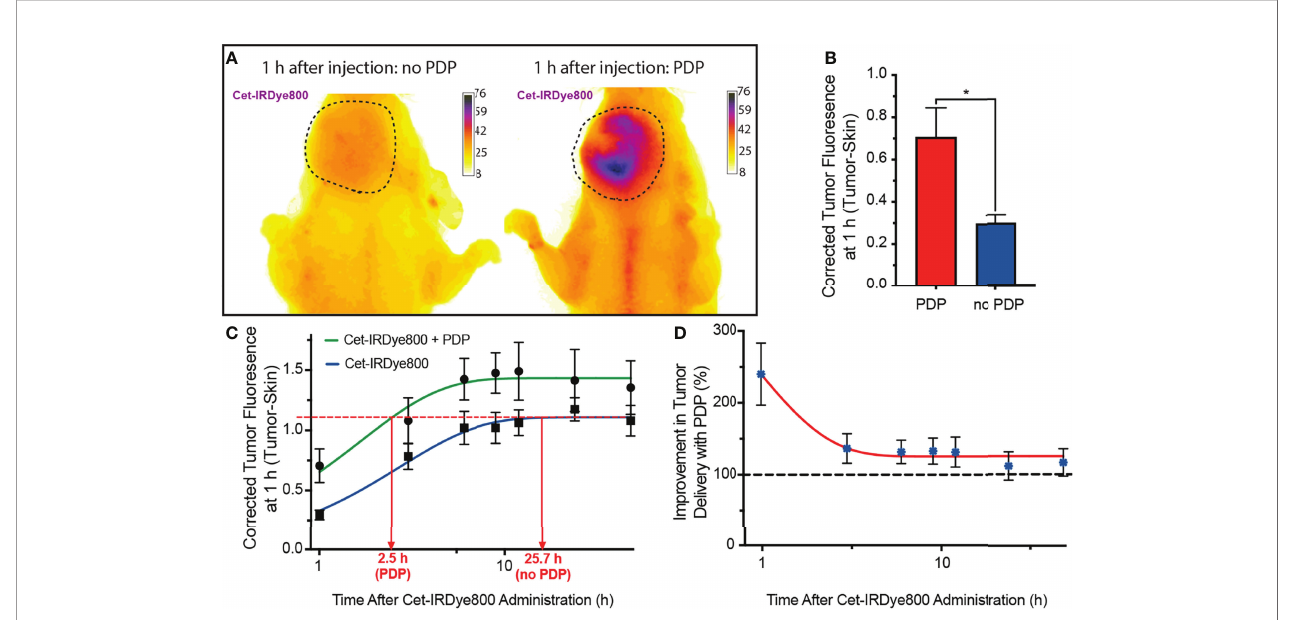
FIGURE 3 | (A) Representative fl uorescence images of Cet-IRDye800 accumulation in orthotopic FaDu head and neck tumors with (right) and without (left) PDP at 1 h following probe administration. (B) Quantitation of tumor accumulation of Cet-IRDye800 at 1 h following probe administration. (C) Longitudinal fl uorescence imaging of Cet-IRDye800 within tumors with and without PDP. (D) Longitudinal non-invasive quantitation of Cet-IRDye800 tumor content in PDP-treated tumors with respect to tumors that were not subject to PDP. (Values are mean ±S.E.M.; statistical analysis was performed using a two-tailed t- test (b); * P ≤